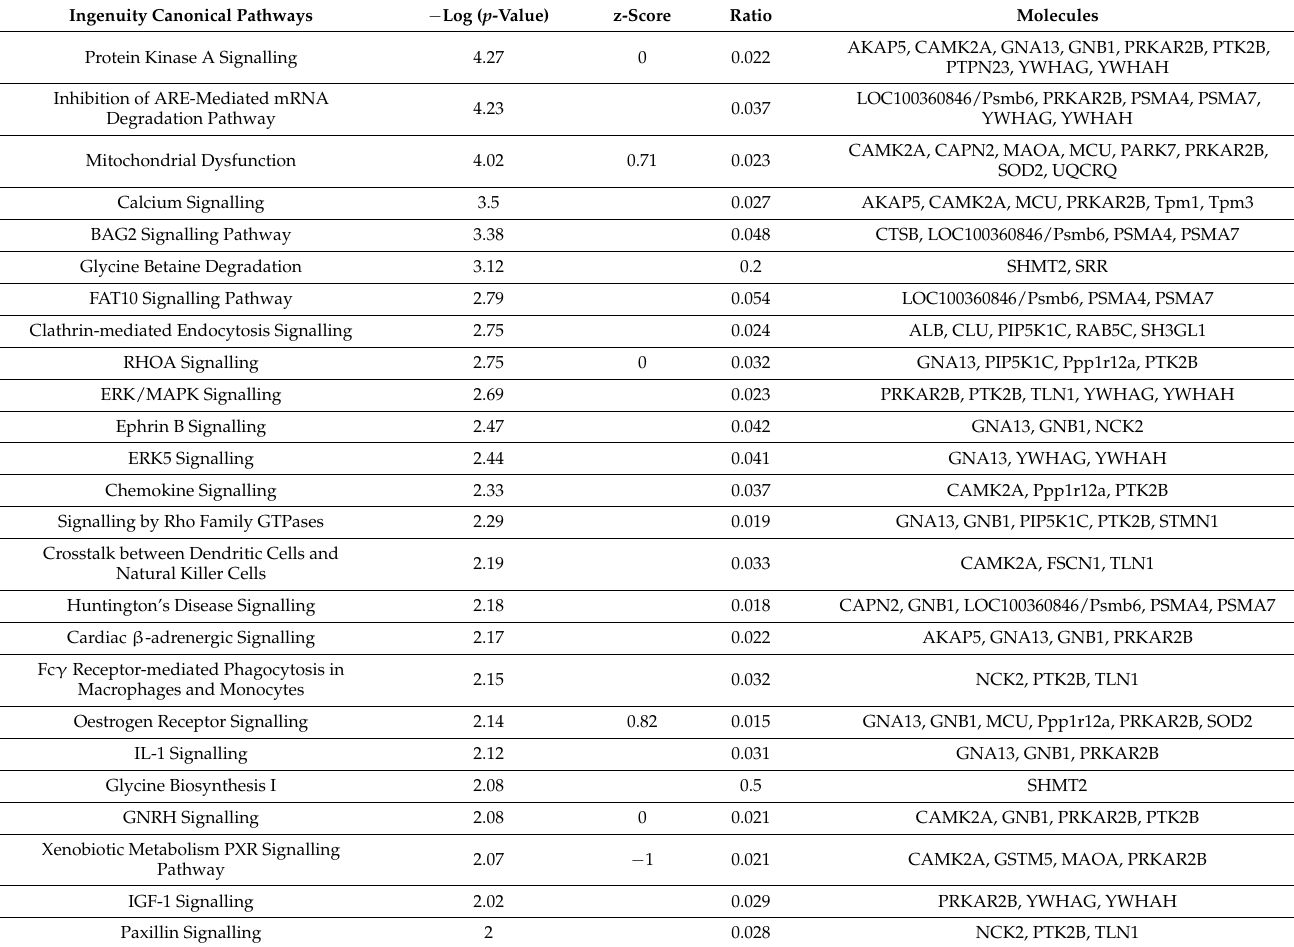
Table 2. Ingenuity canonical pathway analysis post-OGD. Significant ingenuity pathway analysis, ranked by − log ( p -value), shows synaptic plasticity (PKA; p = 5.3 × 10 − 5 ) and OGD-associated transcript degradation ( p = 5.8 × 10 − 5 ), in addition to mitochondrial dysfunction ( p = 9.5 × 10 − 5 ) amongst the top pathways, compared to normoxia-treated